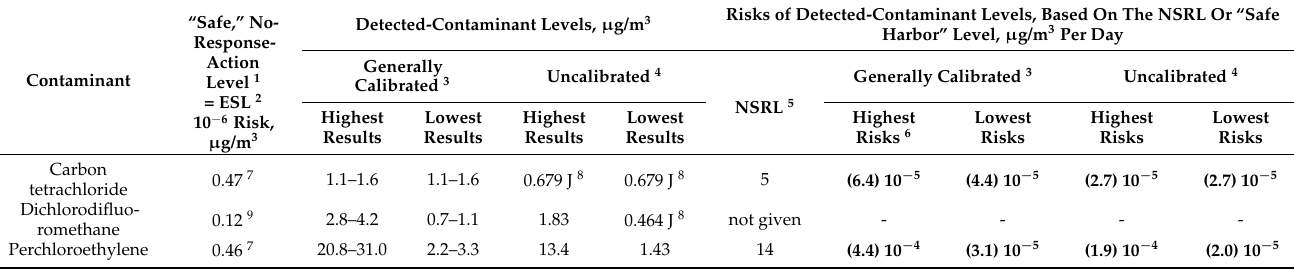
Table 7. Violations of the Second Safety Benchmark, No Significant Risk Level (NSRL), Indoor-Air Passive Samplers, Former Naval Ordnance Testing Station, Pasadena, California (NOTSPA). Bold =